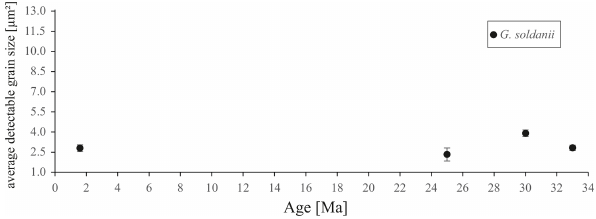
Figure 8. Average detectable grain sizes of four Gyroidinoides sol- danii specimens with 1µm sampling resolution. Error bar indicates 2SE (standard error). Table 1. Average detectable grain size of four Gyroidinoides sol- danii specimens, 1µm step size. SE stands for standard